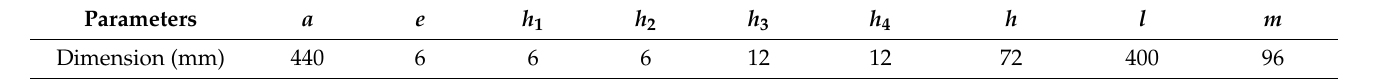
Figure 12. ( a ) A 113-m-offshore deck cargo ship. ( b ) Power cabin of ship. ( c ) Platform of power cabin. Table 5. Dimensions of the sandwich plate structure at the real ship scale (unit/mm).